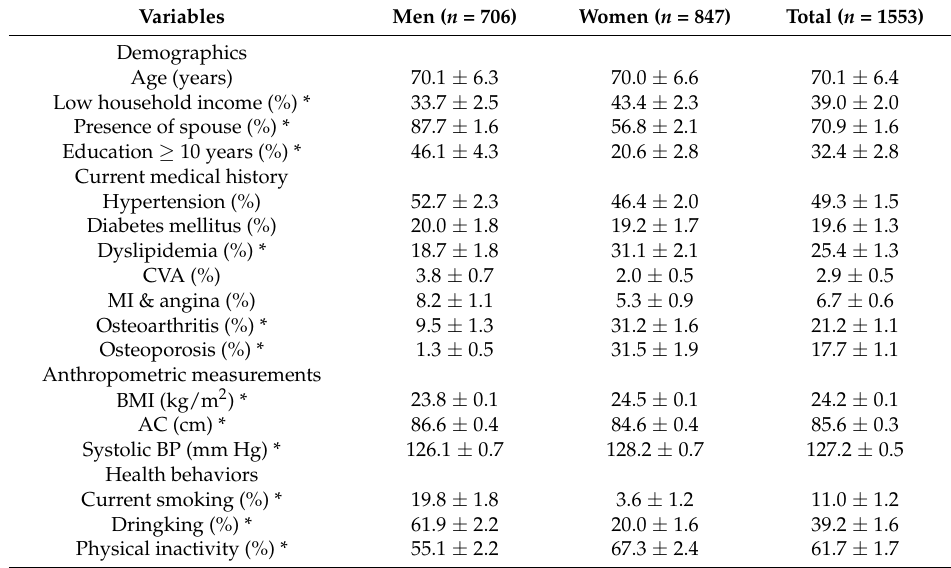
Table 1. Demographic characteristics of study subjects in the 2016 KNHANES VII-1.